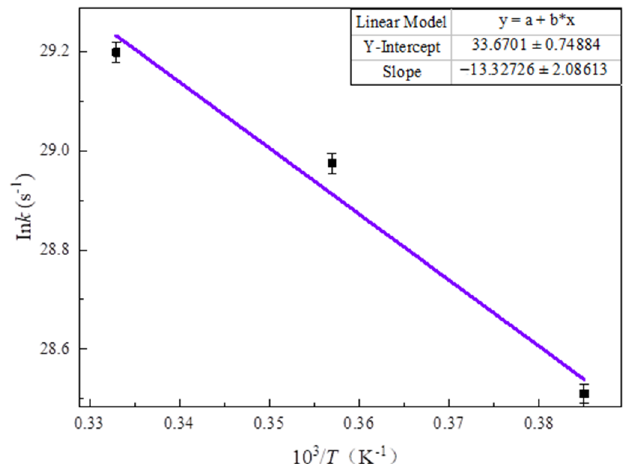
Figure 26. Fitted napierian logarithm of the rate constant k versus inverse temperature T obtained from simulations of cellobiose pyrolysis at 2600–3000 K.